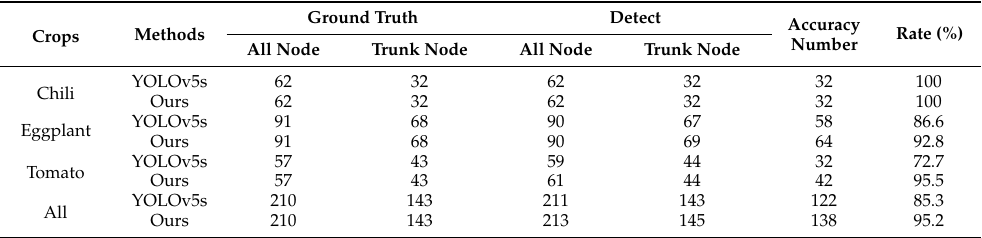
Table 4. Determination of the accuracy of the node order.